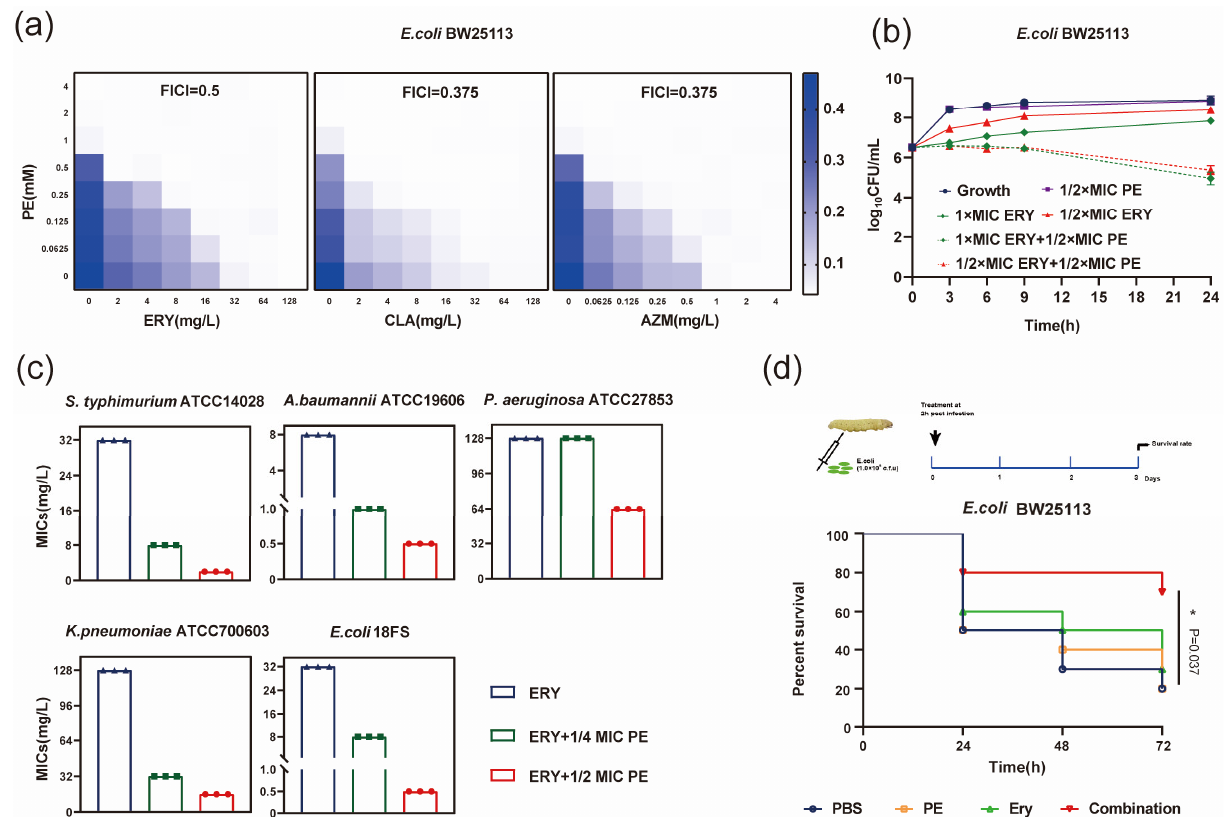
Figure 1. Potentiation of phentolamine (PE) in combination with the indicated macrolide antibiotics against test strains. ( a ) Checkerboard assay results for the indicated macrolides are shown as 8 × 8 matrix heat map graphs, and blue color intensity gradients represent bacterial cell densities (OD 600 ). ( b ) Time–kill curves for E. coli BW25113 over 24 h following exposure to PE (1/2 × MIC) in the presence of increasing ERY. ( c ) MICs of ERY for different species of Gram-negative bacteria exposure to PE (1/4-1/2 × MIC). ( d ) Therapeutic effects of phentolamine combined with erythromycin in the G. mellonella model. Larval survival for phentolamine and erythromycin alone and in combination. * p < 0.05.